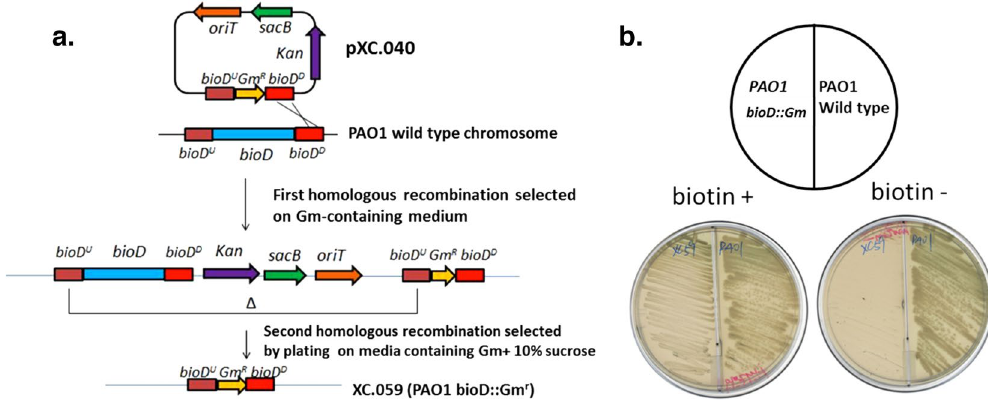
Figure 6. Construction and characterization of the P. aeruginosa bioD::Gm strain. ( a) Recombination events required to generate the mutant strain by sacB counterselection gene replacement. ( b) Characterization of the mutation by biotin complementation. Strain XC.059 was streaked on M9 defined medium plates containing 40 nM biotin (left plate) or lacking biotin (right plate) Abbreviations: kan, kanamycin-resistant gene; Gm R , Gm resistant marker; ori, pMB1 origin of replication; oriT , origin of transfer; sacB , levansucrase-encoding